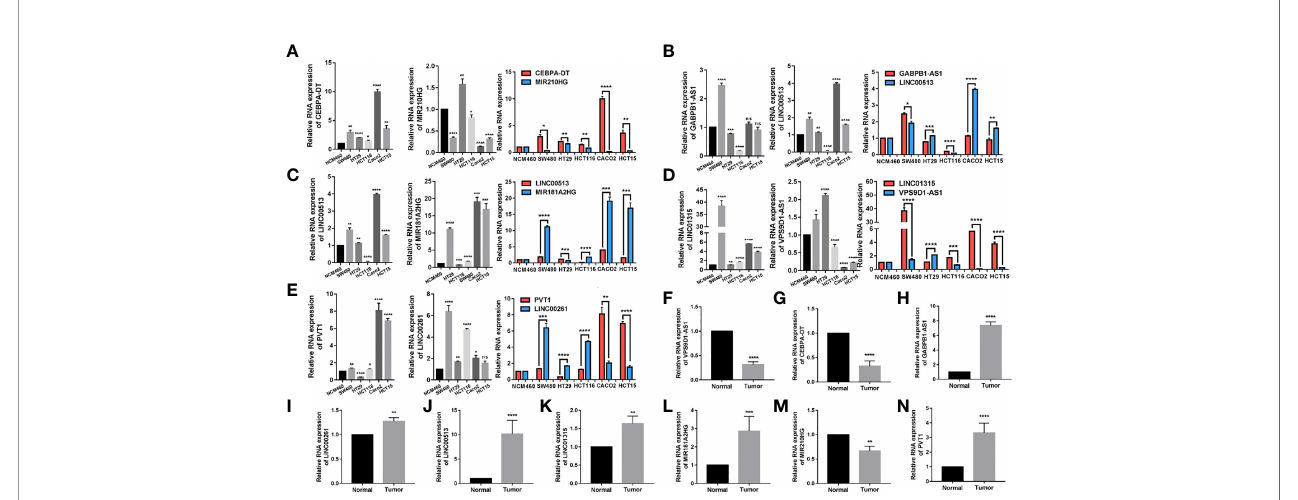
FIGURE 9 | qRT-PCR validation of lncRNA expression levels in different tissues and cell lines. The expression levels of (A) CEBPA-DTM|R210HG, (B) GABPB1-AS1| LINC00513, (C) LINC00513|MIR181A2HG, (D) . LINC01315|VPS9D1-AS1 and (E) PVT1|LINC00261 in different cell lines (NCM460, SW480, Caco2, HCT15, HCT116, and HT29) were measured. (F – N) The expression levels of these lncRNAs in patients of colon cancer and their adjacent normal tissues (N=4) were measured. Results were normalized to reference gene GAPDH. (*P < 0.05, **P < 0.01, ***P < 0.001, ****p < 0.0001; ns, not signi fi cant).